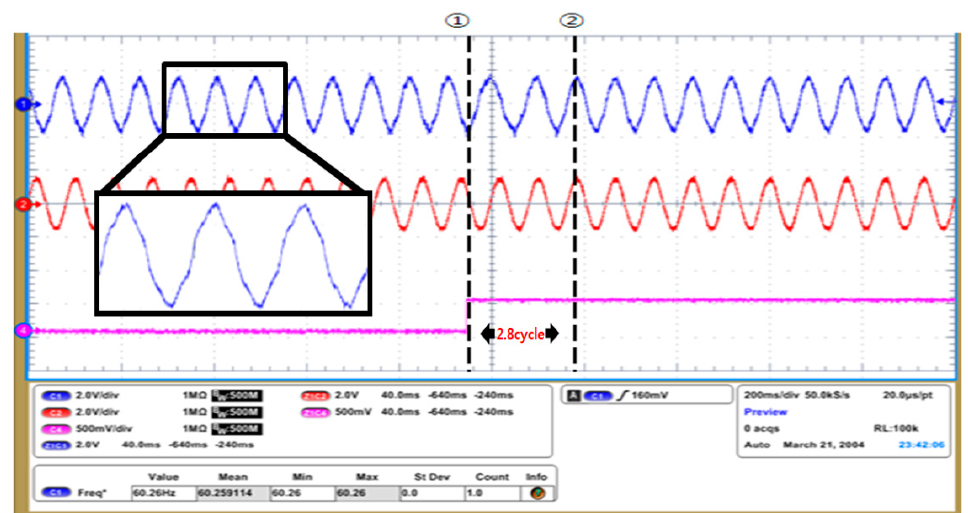
Figure 21. Experimental results in Case II. (SBGS ⟶ GS Mode) (From top to bottom: Measured a -phase inverter output voltage and grid voltage (200 V/div), and GS status signal (0 or 1)), ( ① : starting point of synchronization. ② : finalized point of synchronization).